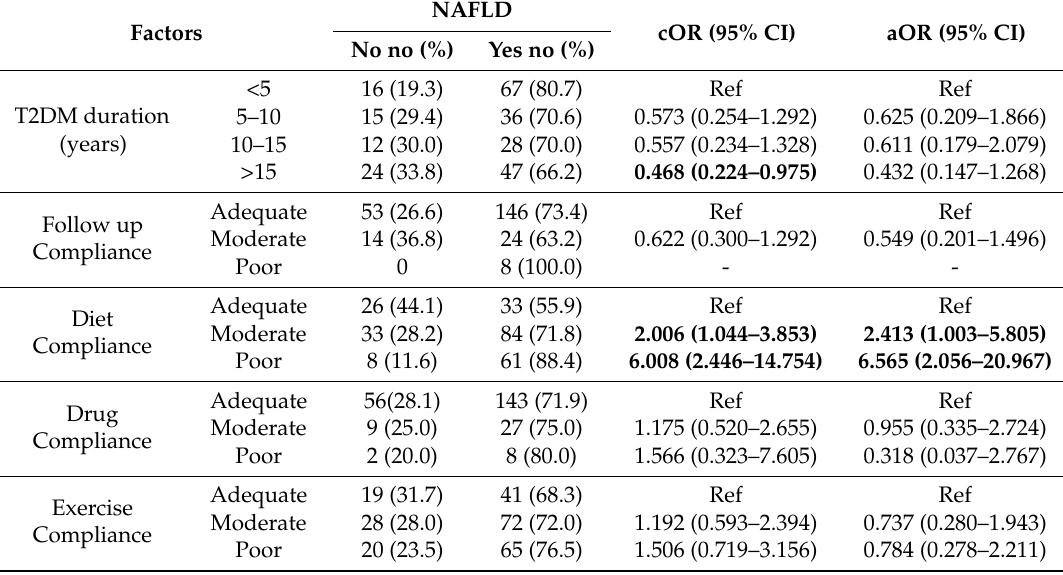
Table 3. Diabetes duration and compliance factors associated with NAFLD among the study sample of T2DM patients ( n =